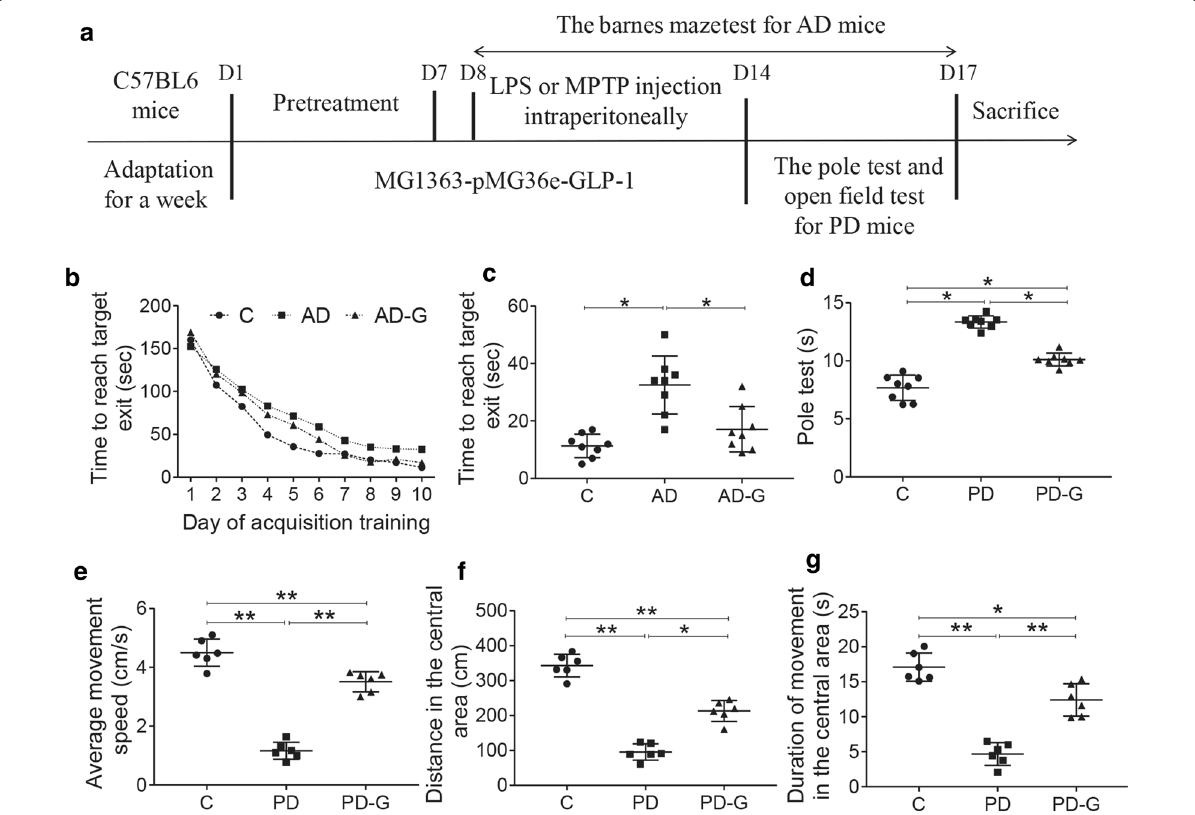
Fig. 1 MG1363-pMG36e-GLP-1 improved cognitive ability in AD mice and motor function in PD mice. a The time schedule to explain the design of the whole experimental design. b The escape latency of mice in the Barnes maze test during the acquisition phase (1–10 days). c The escape latency of mice in the Barnes maze test on the last day. MG1363-pMG36e-GLP-1 had greatly reduced the escape latency. d MG1363-pMG36e-GLP-1 improved the bradykinesia mice induced by MPTP (pole test). e MG1363-pMG36e-GLP-1 increased the distance in the central area moved for PD mice (open-field test). f MG1363-pMG36e-GLP-1 increased the average movement speed for PD mice (open-field test). g MG1363-pMG36e-GLP-1 increased the duration of movement in the central area for PD mice (open-field test). C, control group (n 8); AD, LPS group (n 5); AD-G, = = LPS 10 9 CFU MG1363-pMG36e-GLP-1 group (n 5); PD, MPTP group (n 8); PD-G, MPTP 10 9 CFU MG1363-pMG36e-GLP-1 group (n 8). Data + = = + = are presented as